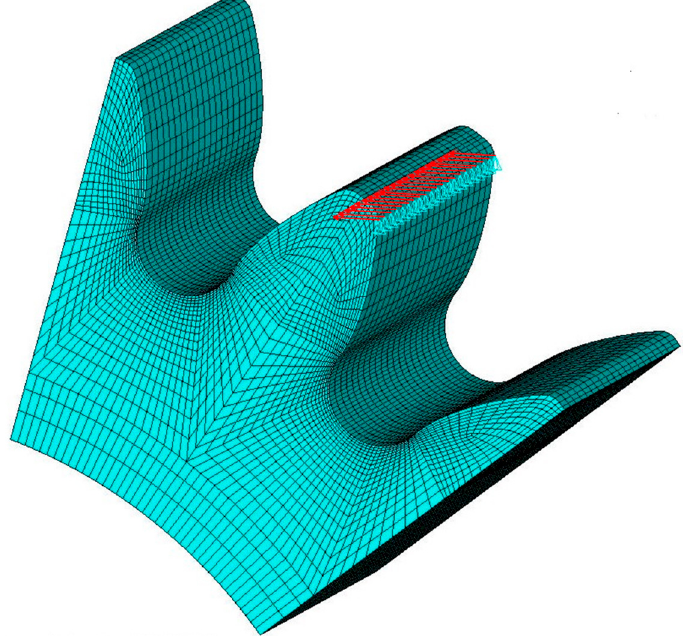
Figure 3. Sub-model of the finite element (FE) analyses carried out to estimate the tooth root bending stress. The applied loads are represented by the red arrows. Image taken from [26].